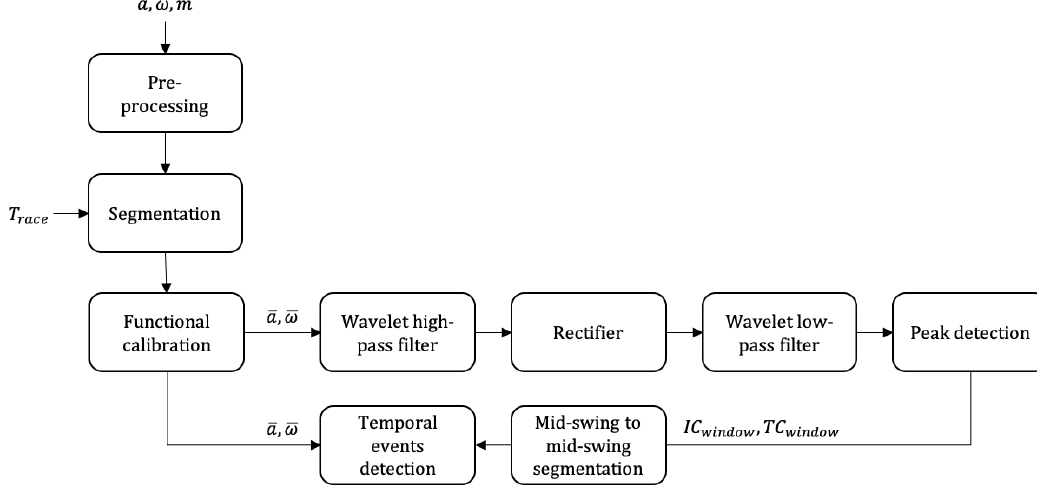
Figure 1. The processing steps added before temporal events detection to improve the segmentation in mid-swing to mid-swing